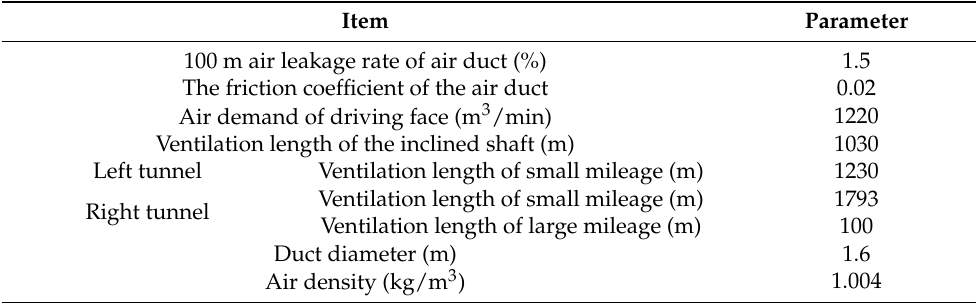
Table 2. Ventilation calculation